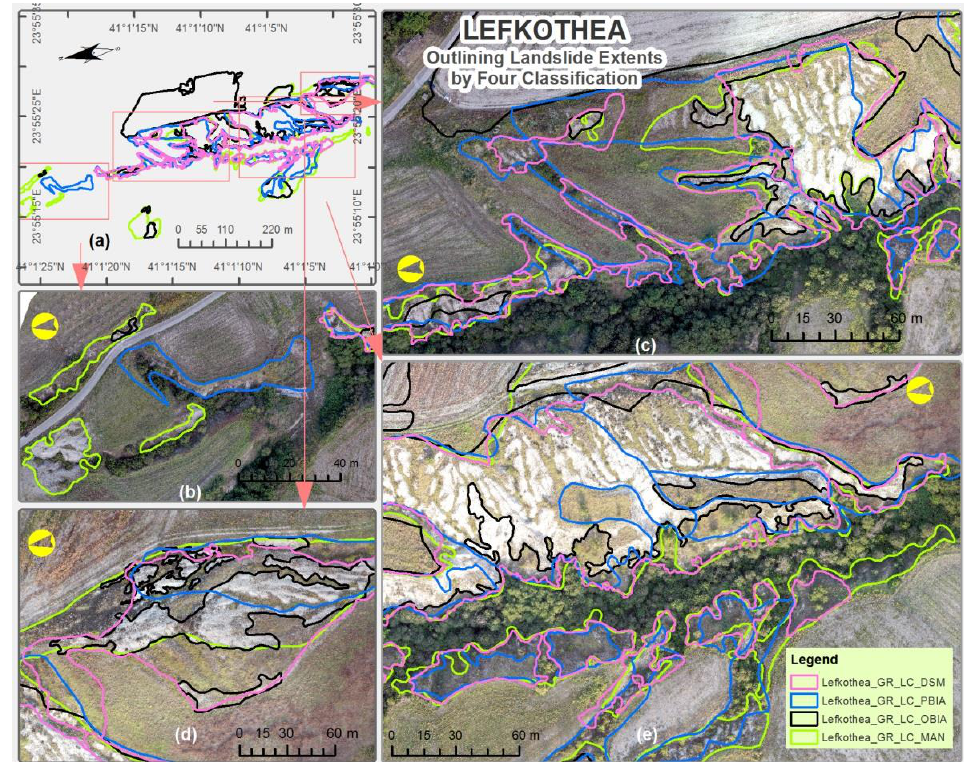
Figure 9. The results concerning Lefkothea’s torrent in Greece captured by the drone flight on 1 September 2021: ( a ) boundaries of affected area, manually digitized; ( b ) segment mean shift (SMS) algorithm; ( c ) ISO Cluster unsupervised classification (based on the orthomosaic), and ( d ) ISO Cluster unsupervised classification (based on the SMS).